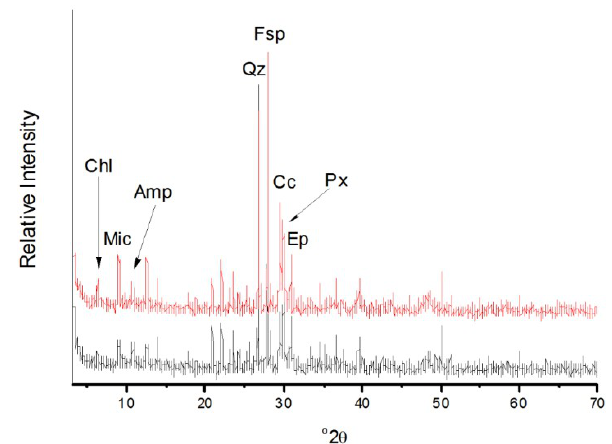
Figure 9. XRD analyses of bulk compositions of representative samples of areas 1 (black color) and 2 (red color); Amp: amphibole (actinolite and glaucophane); Cc: calcite; Chl: chlorite; Ep: (epidote and zoisite); Fsp: feldspar; Mic: mica; Px: pyroxene; Qz: quartz.